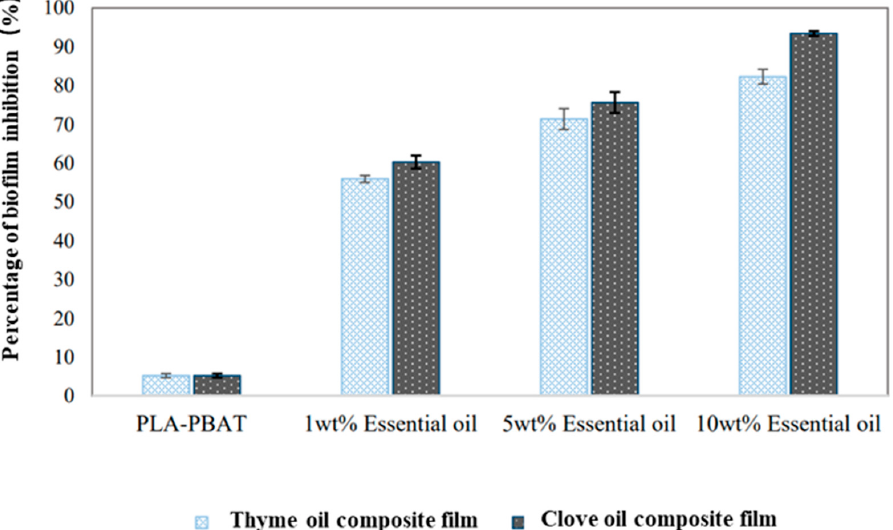
Figure 6. Biofilm inhibition of PLA/PBAT-thyme oil composite film and PLA/PBAT-clove oil composite film against E. coli. Ref. [89], published by MDPI, 2020. Ahmed et al. [90] used poly (caprolactone) (PCL) and polyethylene glycol (PEG) as